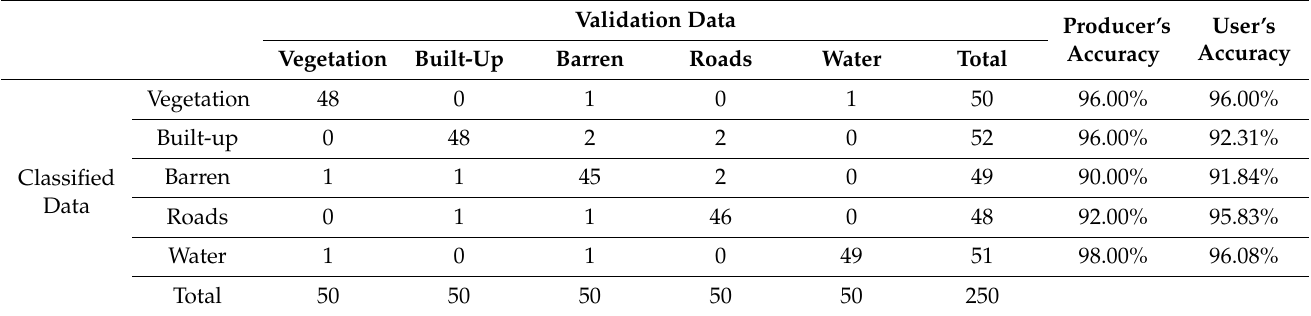
Table 3. Error matrix, producer’s accuracy, and user’s accuracy for LULC classification of LANDSAT 7